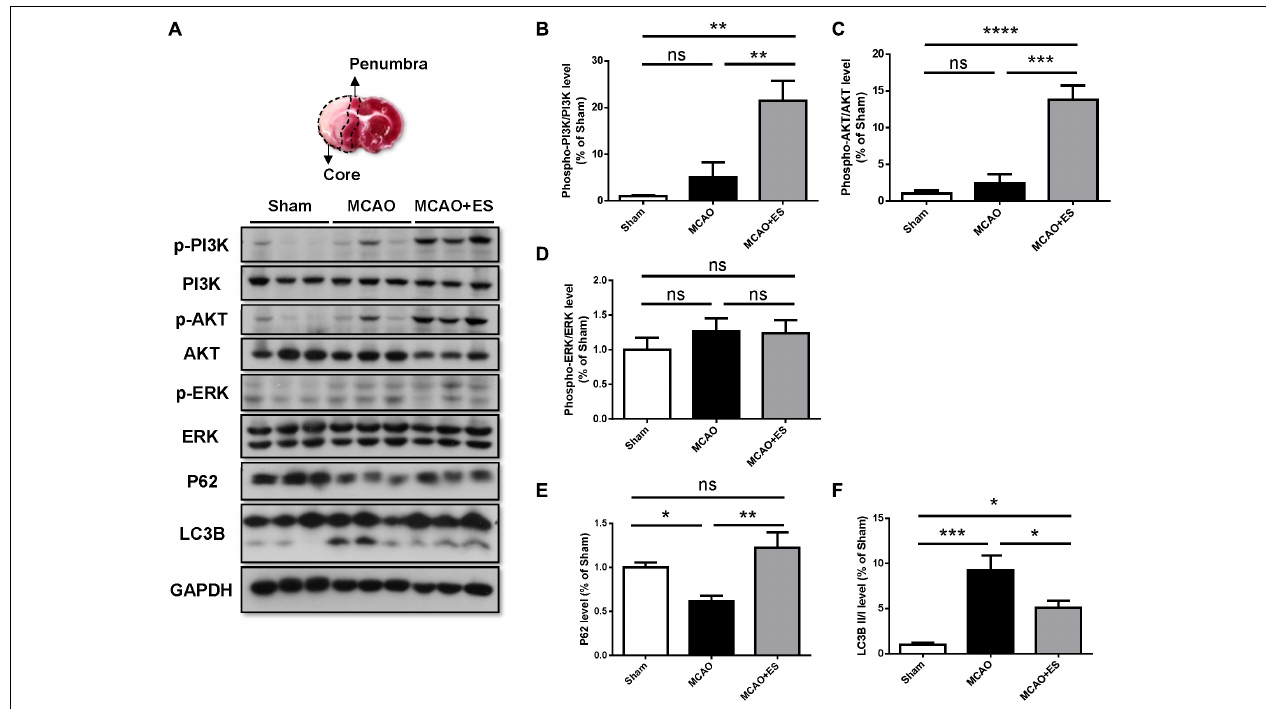
FIGURE 7 | Cortical ES treatment activated the PI3K/Akt pathway and suppressed autophagy to protect the brain from ischemia/reperfusion injury after tMCAO. Western blotting for PI3K, Akt, extracellular signal-regulated kinase (ERK), P62, and LC3B. (A) Representative pictures of Western blot. The upper panel represents the 2,3,5-triphenyltetrazolium chloride (TTC)-stained view of demarking core and penumbral region. (B,C) Phosphorylation of PI3K and Akt were significantly upregulated in ES groups. (D) There was no significant change in the phosphorylation of ERK. (E,F) In the ES group, there were increased P62 and reduced LC3B, indicating suppression of autophagy by ES ( n = 5 for each group). * p < 0.05; ** p < 0.01; *** p < 0.001; and **** p <